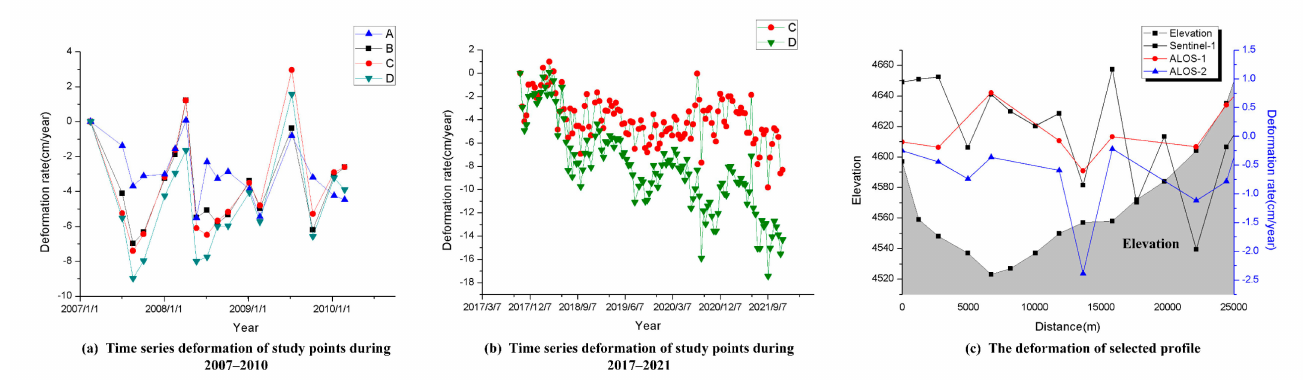
Figure 5. The time series deformation of the study points and the deformation of the selected profile. ( a ) Time series deformation of study points during 2007–2009. ( b ) Time series deformation of study points during 2017 to 2021. ( c ) The deformation of selected